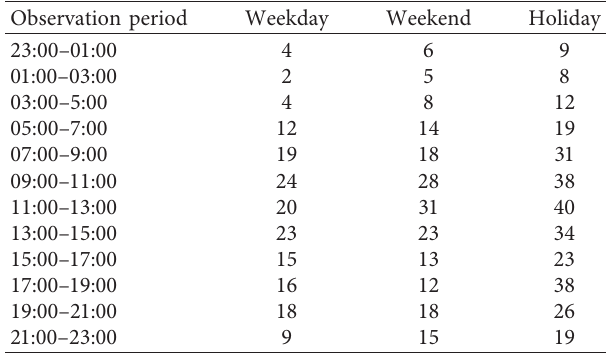
Table 4: The flights arrival in different periods of a certain domestic